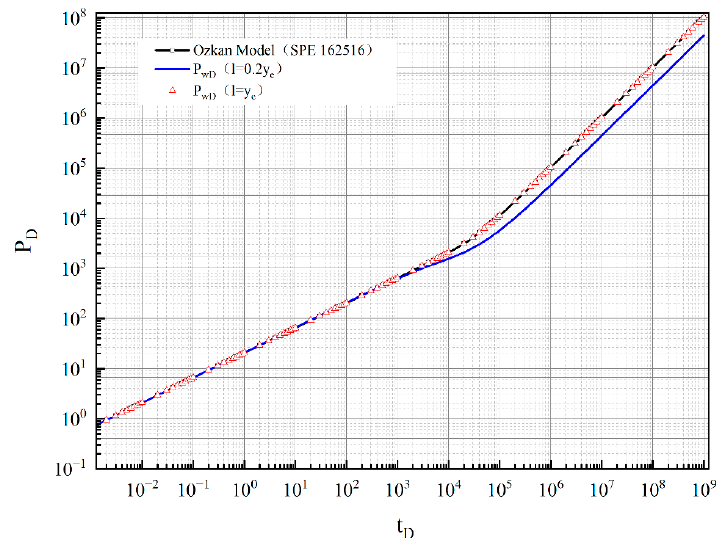
Figure 5. Model verification and comparison.